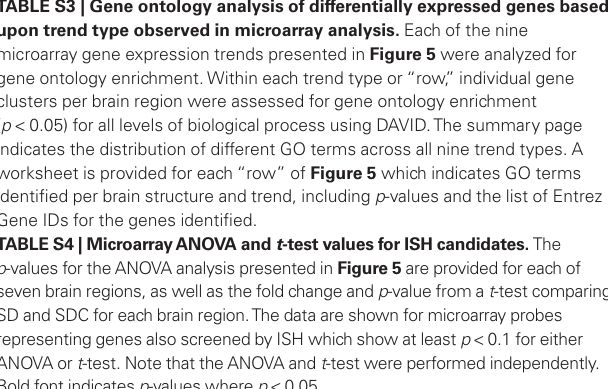
TABLe S3 | gene ontology analysis of differentially expressed genes based upon trend type observed in microarray analysis. Each of the nine microarray gene expression trends presented in Figure 5 were analyzed for gene ontology enrichment. Within each trend type or “row,” individual gene clusters per brain region were assessed for gene ontology enrichment ( p < 0.05) for all levels of biological process using DAVID. The summary page indicates the distribution of different GO terms across all nine trend types. A worksheet is provided for each “row” of Figure 5 which indicates GO terms identified per brain structure and trend, including p -values and the list of Entrez Gene IDs for the genes identified. TABLe S4 | Microarray ANOVA and t -test values for iSH candidates. The p -values for the ANOVA analysis presented in Figure 5 are provided for each of seven brain regions, as well as the fold change and p -value from a t -test comparing SD and SDC for each brain region. The data are shown for microarray probes representing genes also screened by ISH which show at least p < 0.1 for either ANOVA or t -test. Note that the ANOVA and t -test were performed independently. Bold font indicates p -values where p <